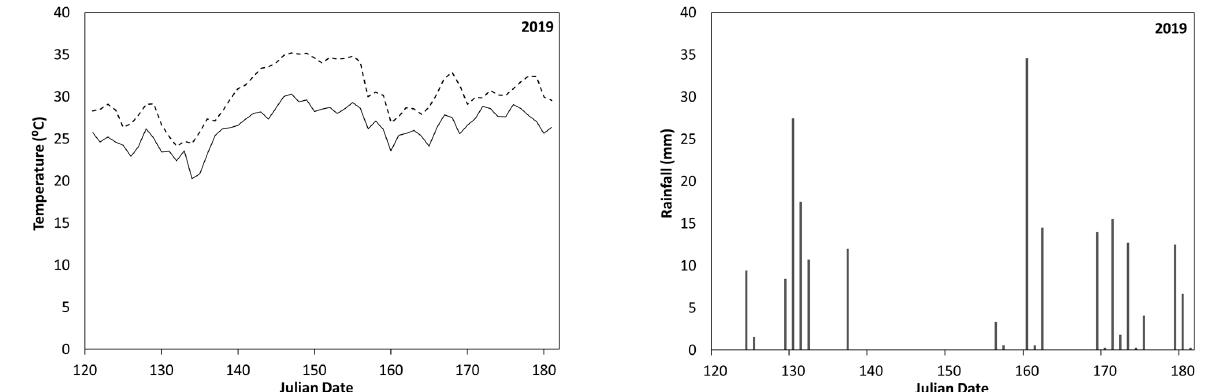
Figure A1. Mean air temperature, soil temperature and rainfall for the months of May and June in 2017, 2018 and 2019.